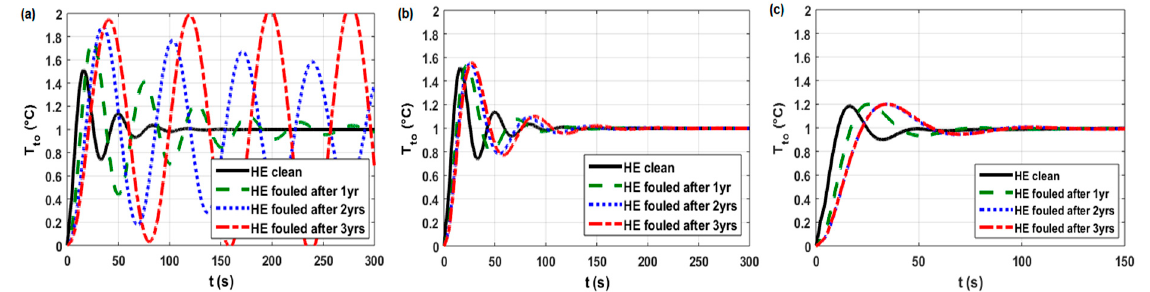
Figure A3. Closed-loop step responses (case in work [6]) under fouling conditions of the HE E30AB models: without adjustment ( a ) after adjustment ( b ) and after adjustment of optimal ( c ) PID tuning parameters.